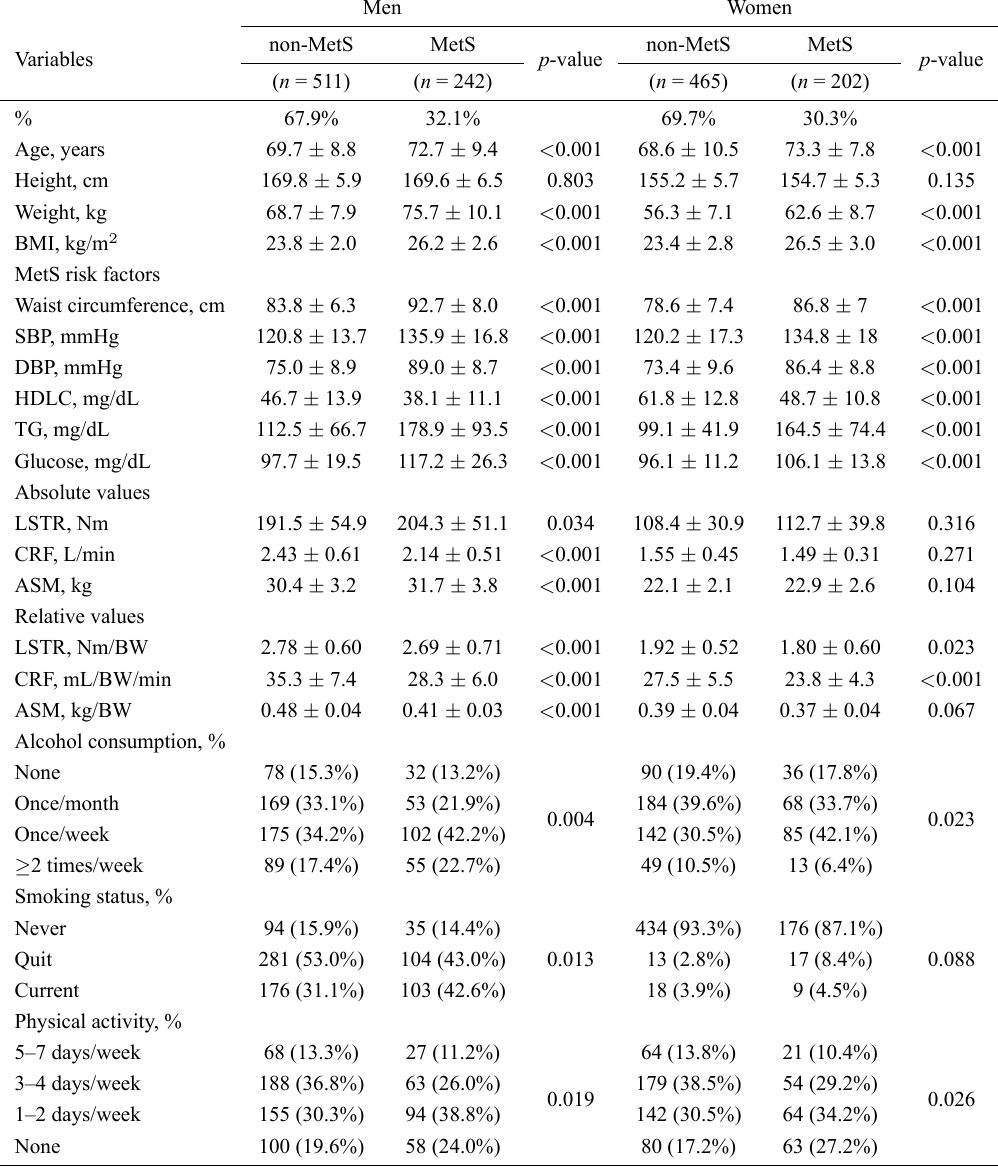
Table 1. General characteristics of